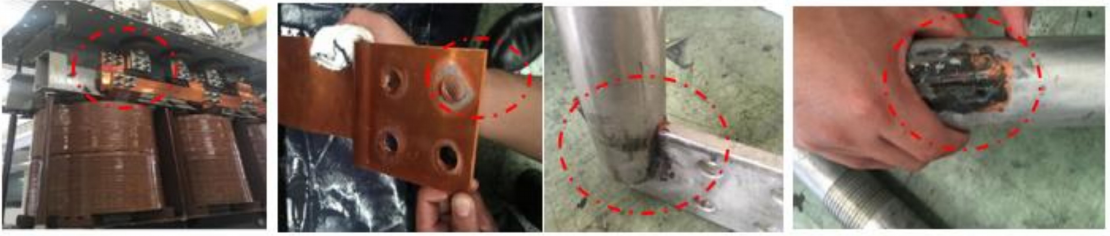
Figure 11. Arcing due to loosened bolts and nuts inside TR2, 22 kV/416 V, 3